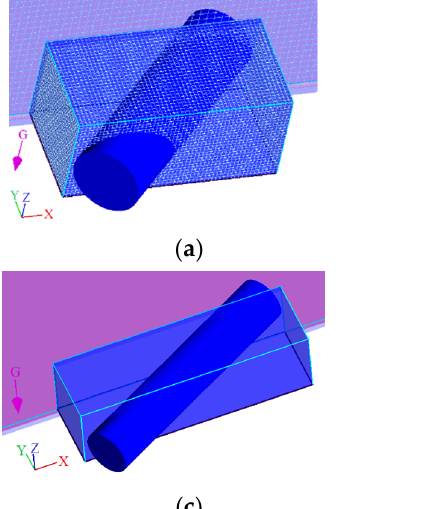
Figure 18. 3D favored view of the channel.